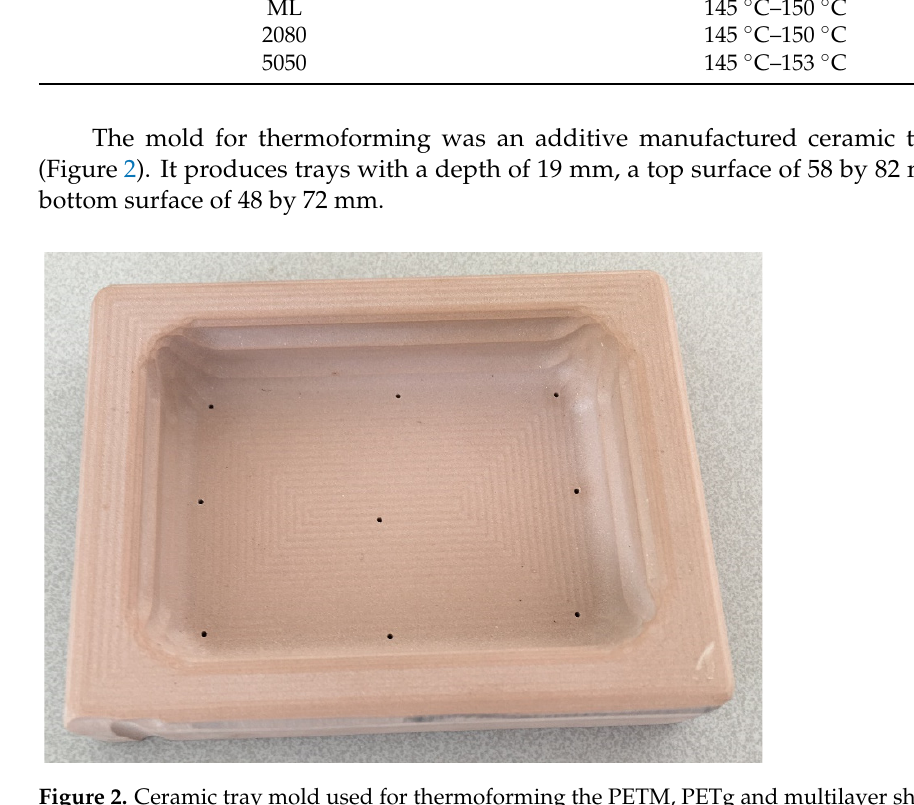
Figure 2. Ceramic tray mold used for thermoforming the PETM, PETg and multilayer sheets.